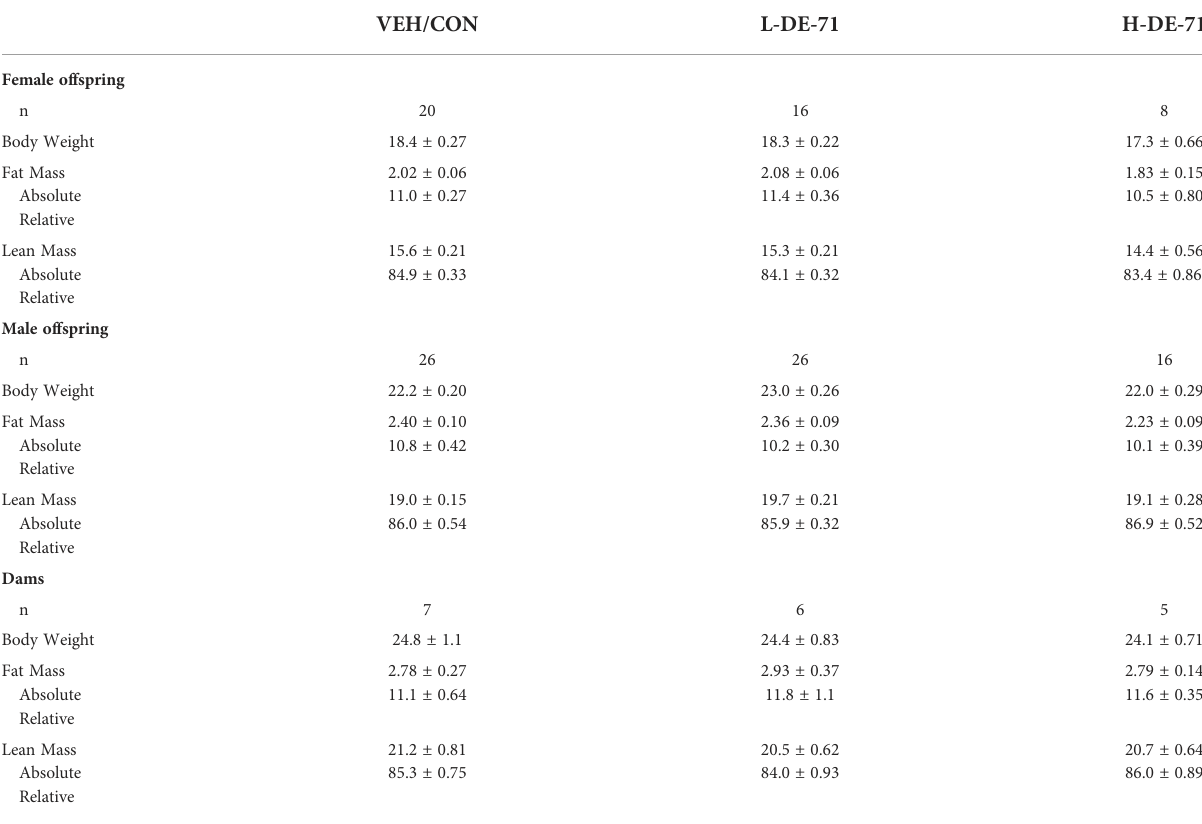
TABLE 2 Chronic DE-71 exposure has minimal effects on body